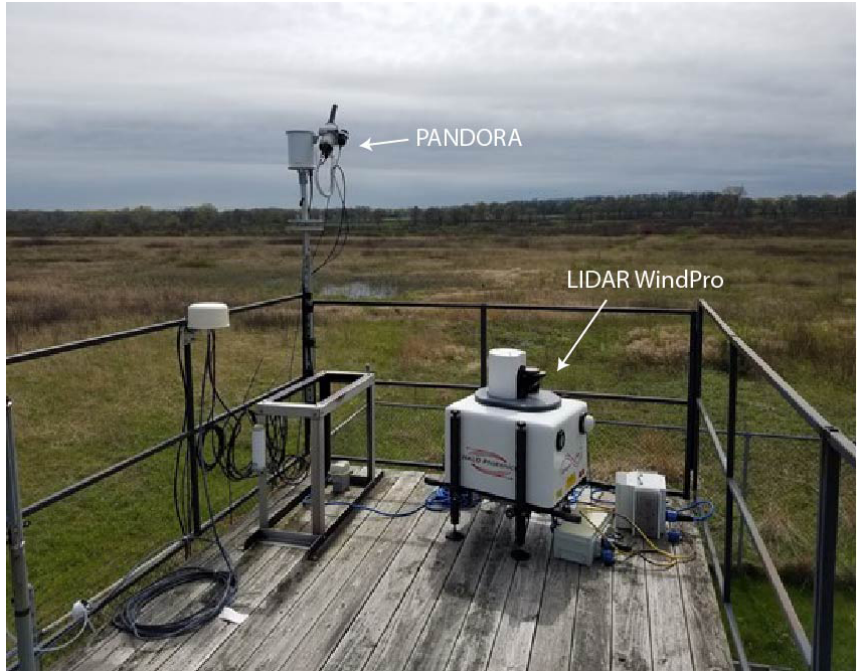
Figure 3. Roof of the Chiwaukee Prairie air monitoring system, showing the PANDORA (upper left) and Doppler lidar (right center). The wooden floor pictured here is approximately